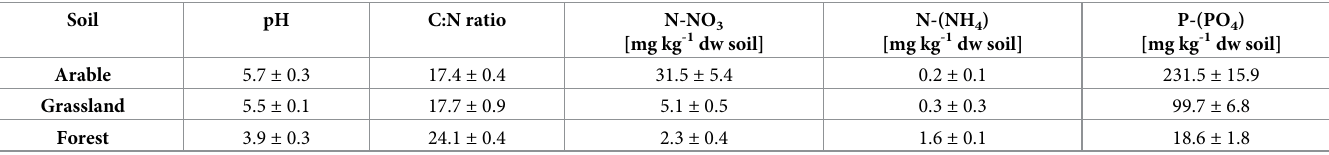
Table 1. Mean values ( ± SE) of chemical soil properties for each of the three soil types (arable, grassland, forest). Soil